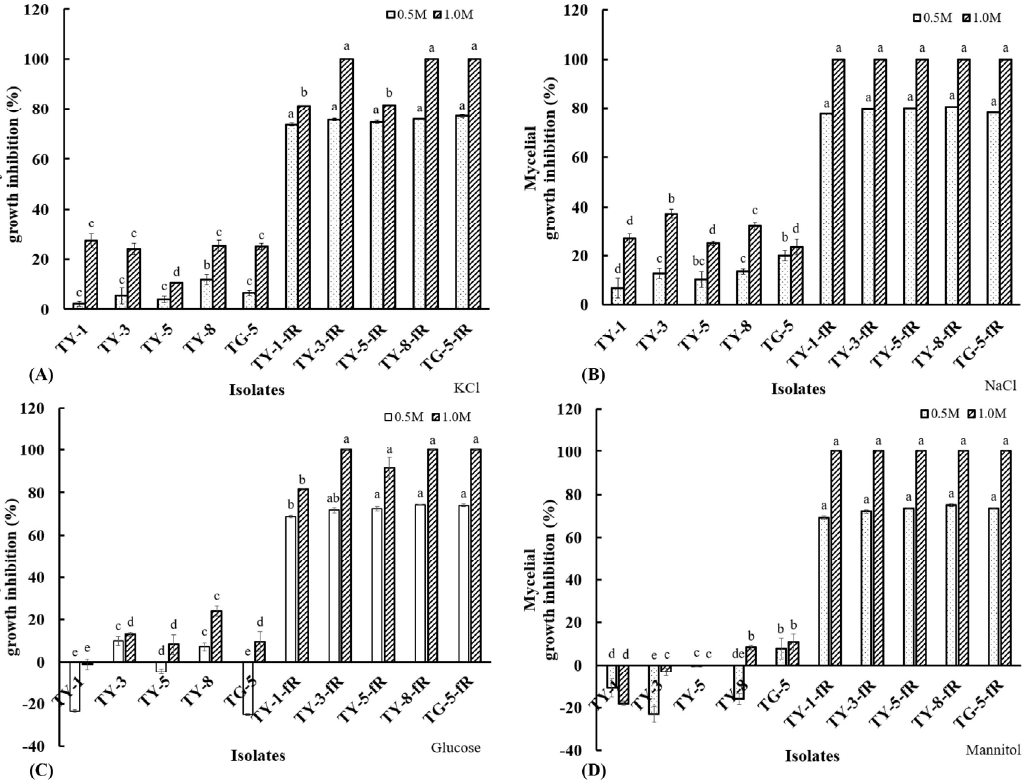
Figure 3. Mycelial growth inhibition of five fludioxonil-resistant mutants (TY-1-fR, TY-3-fR, TY-5-fR, TY-8-fR, and TG-5-fR) of FOM and their sensitive parental isolates (TY-1, TY-3, TY-5, TY-8, and TG-5) in response to osmotic stress induced by ( A ) KCl, ( B ) NaCl, ( C ) Glucose, ( D ) Mannitol at final concentrations of either 0.5 or 1 M. Data are the means of 12 replicates ± SE. Error bars indicate one standard error of the mean (SE) as calculated from the mean of two separate experiments, while different letters above columns indicate significant differences according to Fisher’s least significant difference test ( p ≤ 0.05). Table 4. Mutations in the predicted FoOs1 protein sequence of five fludioxonil-resistant mutants of